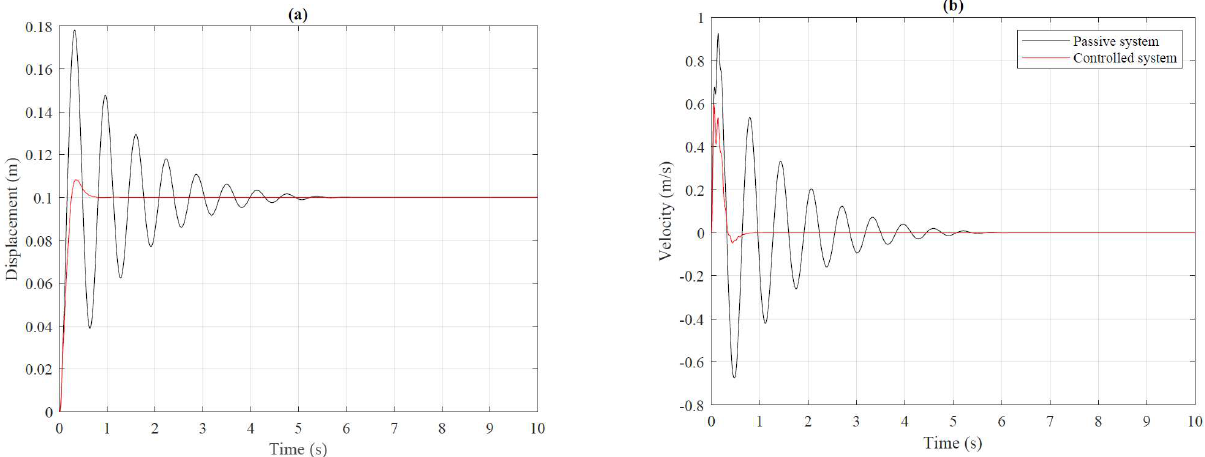
Figure 8. Vertical displacement ( a ) and vertical velocity ( b ) of the vehicle body in the center of mass.